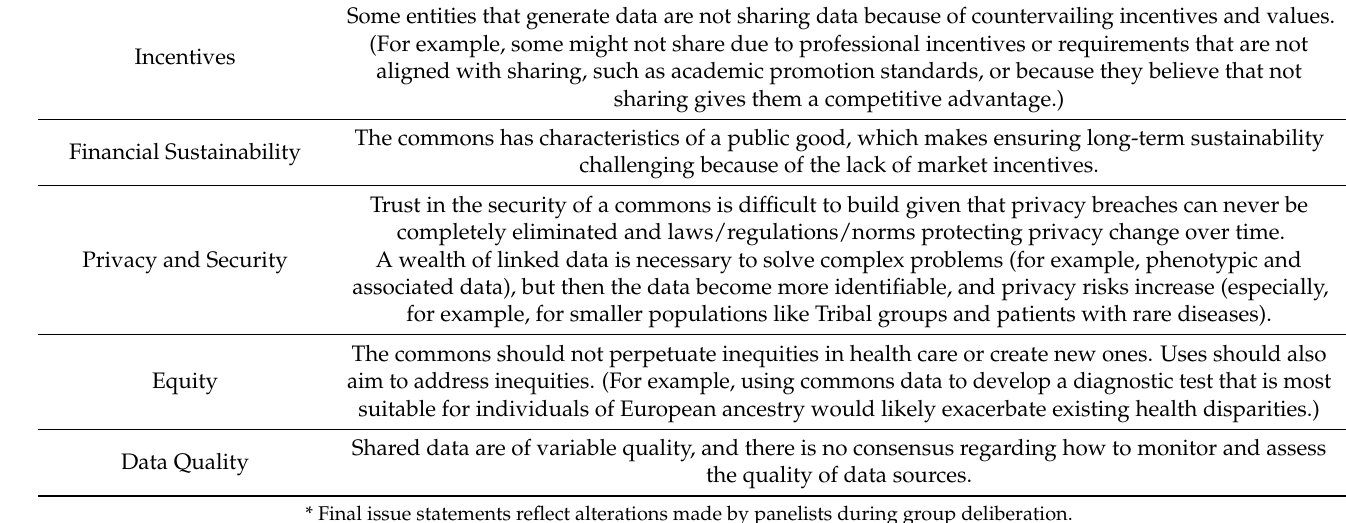
Table 1. Domains and Related High-Priority Issue Statements